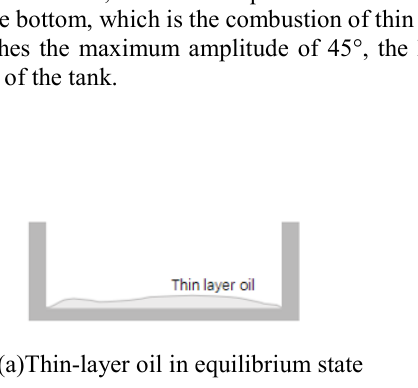
Fig. 7. Oil flow in oil